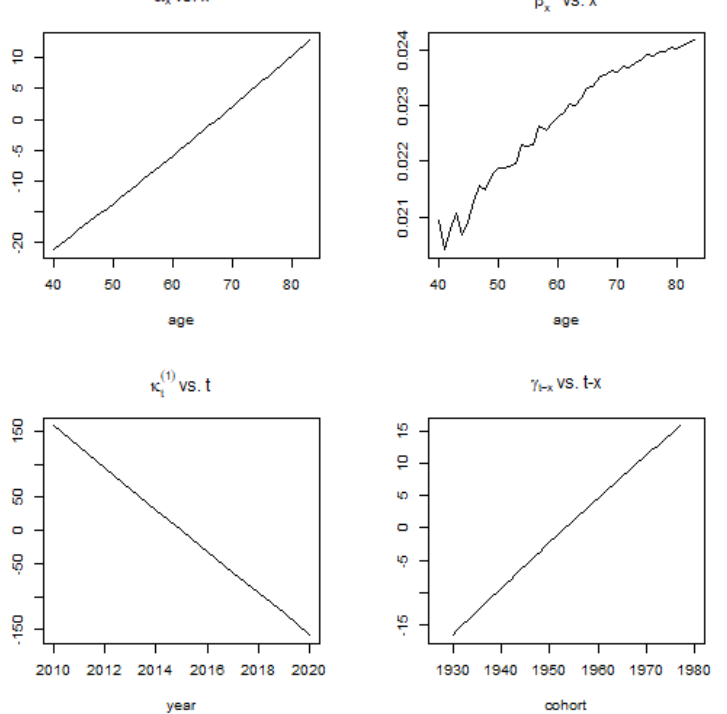
Figure 4. Renshaw–Haberman Parameters fitted to the Ghana Pension Population for Ages 40–83 and the Period